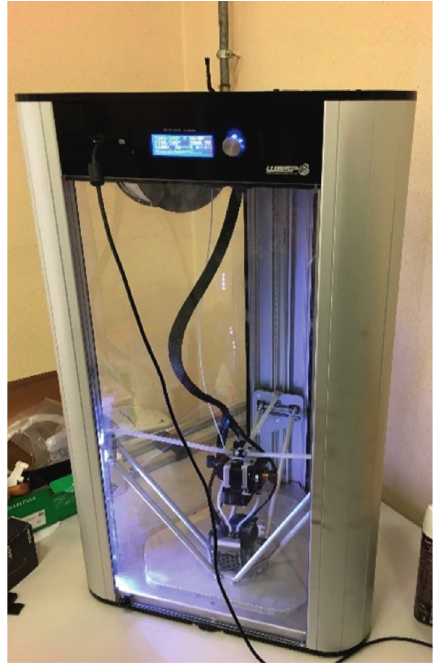
Figure 2: 3D printer, Delta Wasp 2040 Turbo 2.